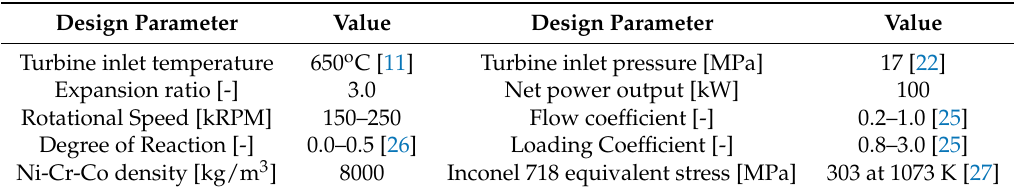
Table 1. Input design